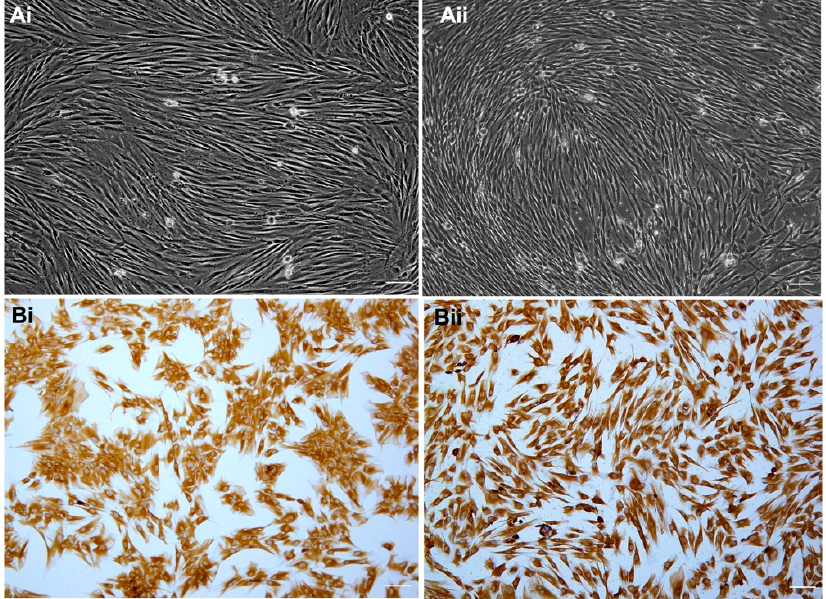
Figure 1. Representative photomicrographs showing: ( A ) confluent cultures of ( i ) spindle-shaped ncHDPCs and ( ii ) cHDPCs, and ( B ) vimentin positive ( i ) ncHDPCs and ( ii ) cHDPCs. All cultures were at passage 4. Scale bar = 100 µm.